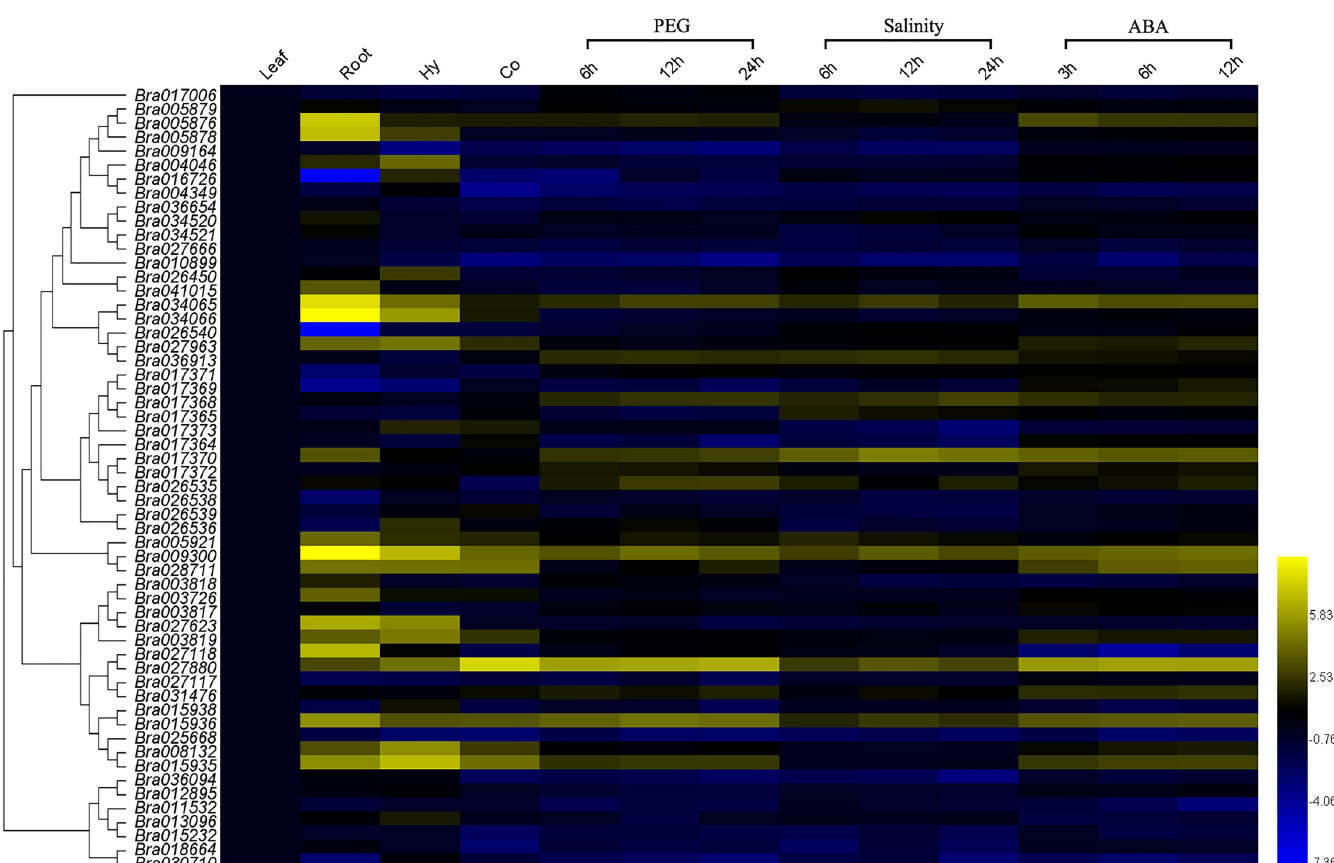
Fig 6. Expression modes of 56 BraSOT genes in brassica tissues and treated with 25% PEG-6000, 200mmol/L NaCl and 100 μ mol/L ABA. The bars display the relative gene expression levels, calculated based on the 2 − ΔΔ Ct method. Gene expression level in leaf with no treatment was used as the reference for calculation. Thus different colour present horizontal comparison of relative expression. The expression level is equal to the mean values and transform log 2 values. Hy, hypocotyl; Co, cotyledon; polyethylene glycol (PEG), drought stress; Salinity, salt stress; ABA, abscisic acid treatment.